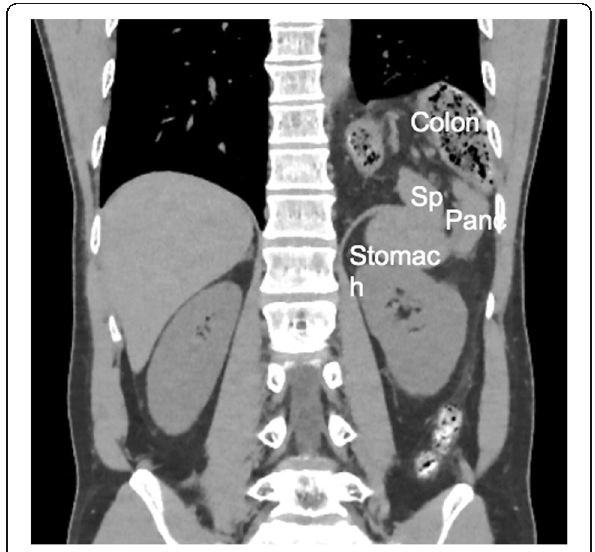
Fig. 2 CT imaging 10 years before surgery showed modestly Fig. 3 After reducing the herniation. The hernia orifice was 7 cm, and there was no hernia